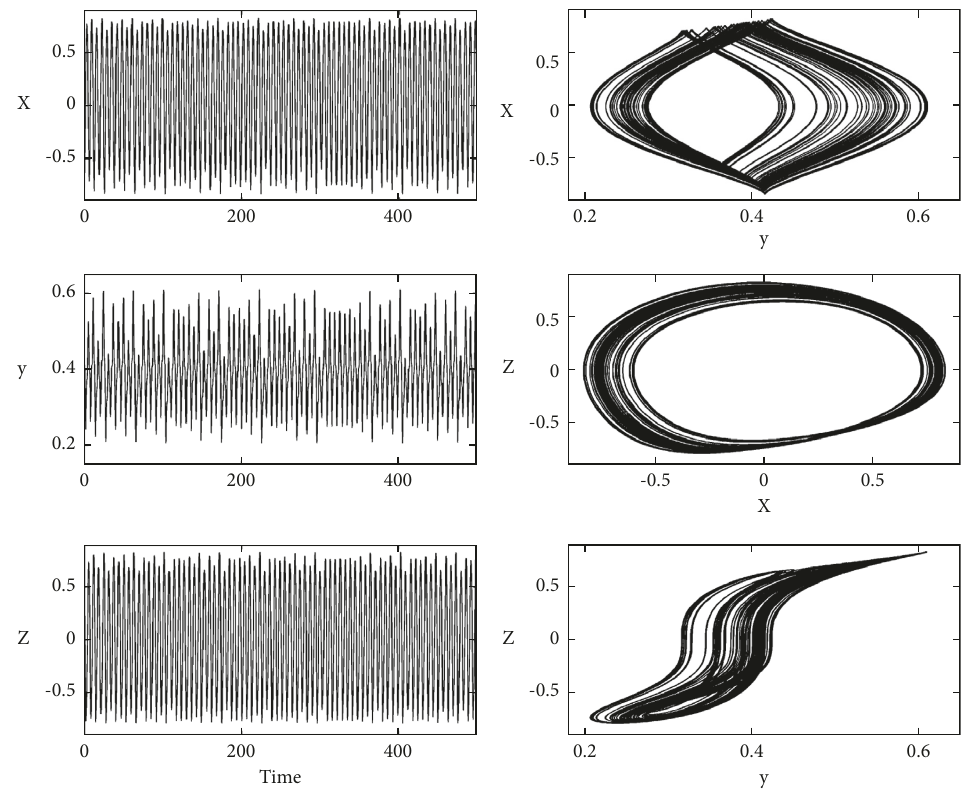
Figure 3: (a) Time series of x